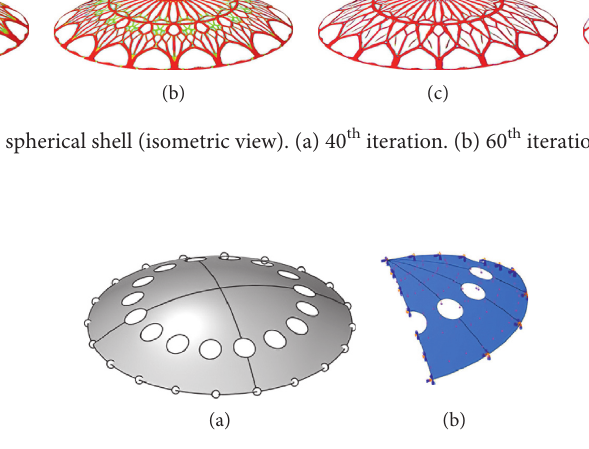
Figure 5: Optimization parameters of spherical shell. (a) Whole structure. (b) 1/4 substructure.